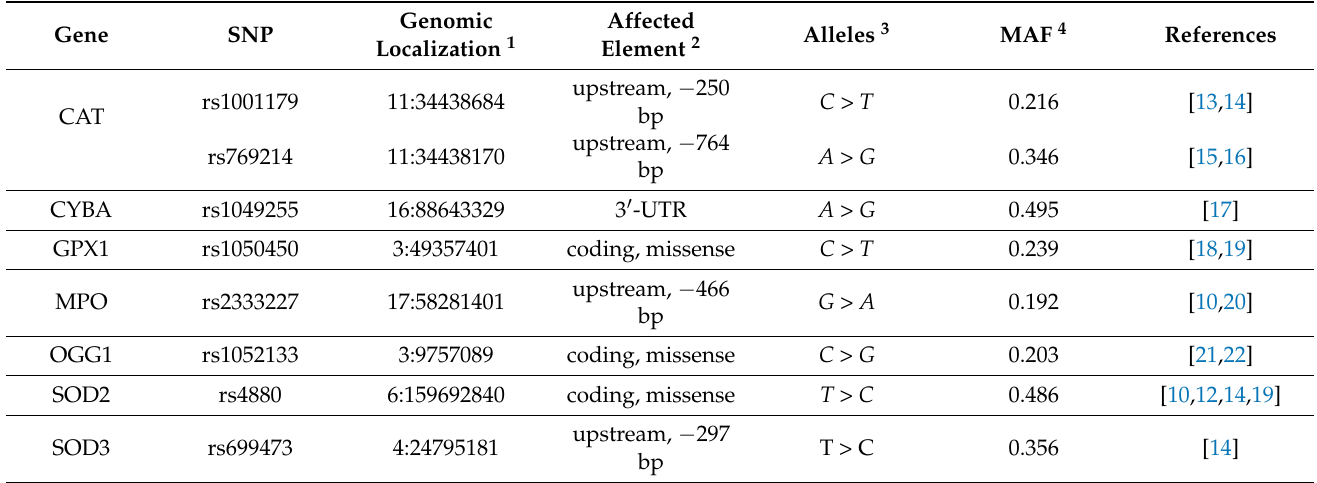
Table 1. Characteristics of the genotyped polymorphisms.